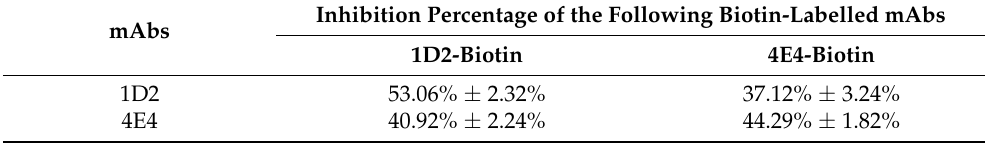
Table 2. There are overlapping antigen epitopes recognized by 1D2 and 4E4 as determined by ELISA. Inhibition Percentage of the Following Biotin-Labelled mAbs